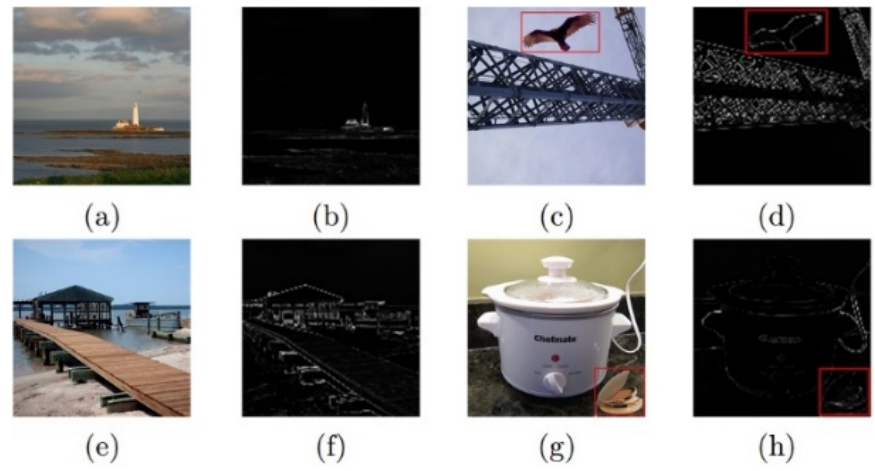
Figure 8. Examples of the sharpness detection results, where ( a – d ) are the images with correct classification, and ( e – h ) are the images with failed classification. ( a , e ) Untampered images; ( b , f ) the sharpness detection results of the untampered images; ( c , g ) tampered images; ( d , h ) the sharpness detection results of the tampered images.